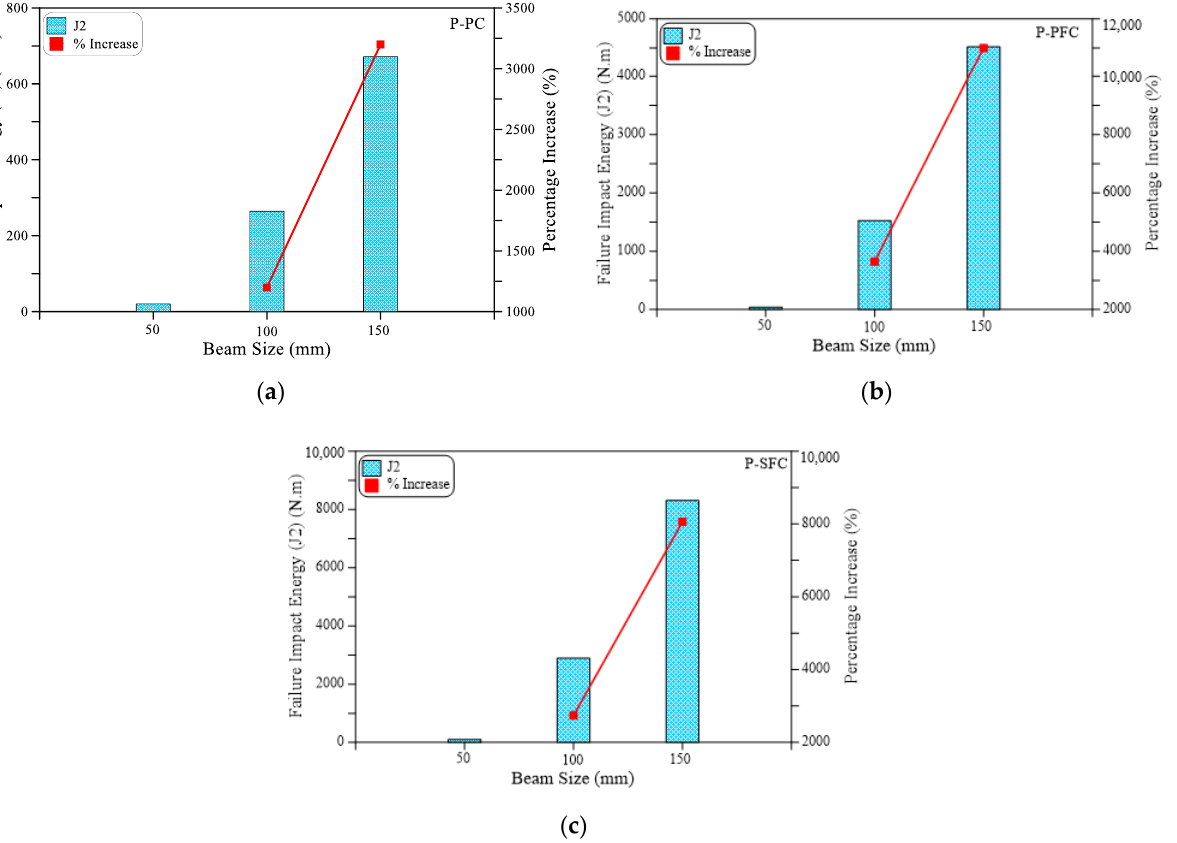
Figure 11. Failure impact energy (J2) of the three beam sizes: ( a ) PC; ( b ) P-PFC; ( c ) P-SFC.